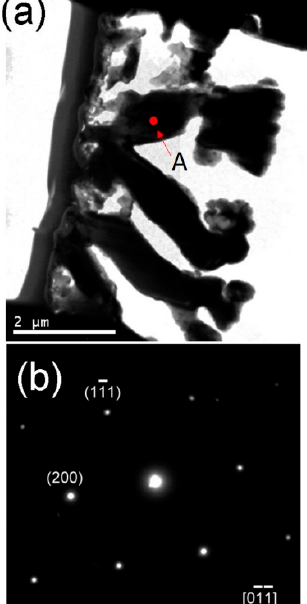
Figure 7. ( a ) Cross-sectional TEM image of porous-type structure and ( b ) diffraction patterns of point A in (a). To further examine the temperature effect on the of porous Cu 3 Sn formation, another set of bumps were aged at 185 °C in the oven without current stressing. In the case of 1000-h aging (Figure